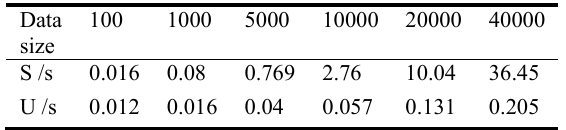
Table 3. Comparison of Silhouette coefficient and